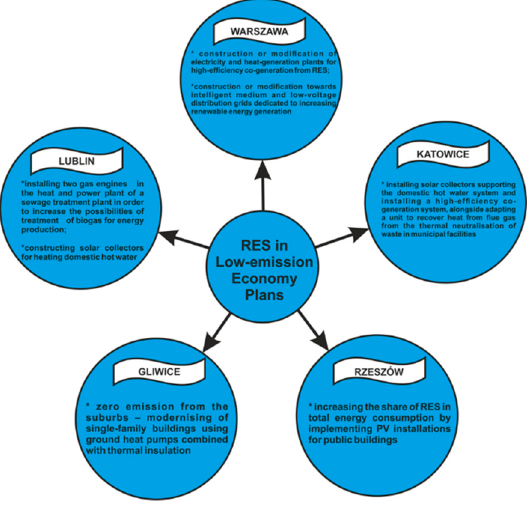
Figure 5. RES in low-emission economy plans. Source: own study based on low-emission economy plans [108–126].